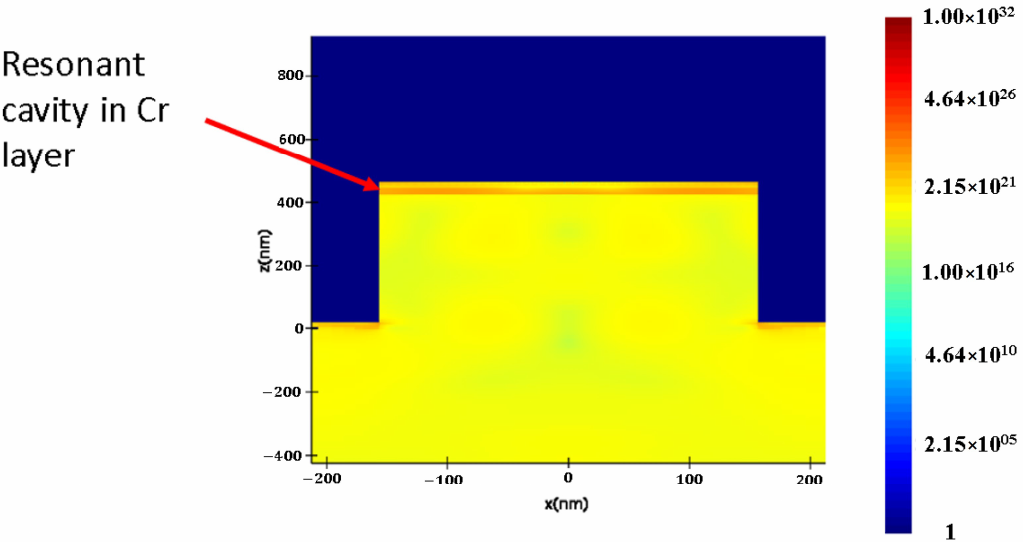
Figure 4. Distribution of optical power absorption ( P abs ) in the Si grating structure at 850 nm wavelength. A resonant cavity forms in the Cr layer for the 850 nm wavelength which is located between the Au top contact and the top Si grating surface (shown by red arrow).